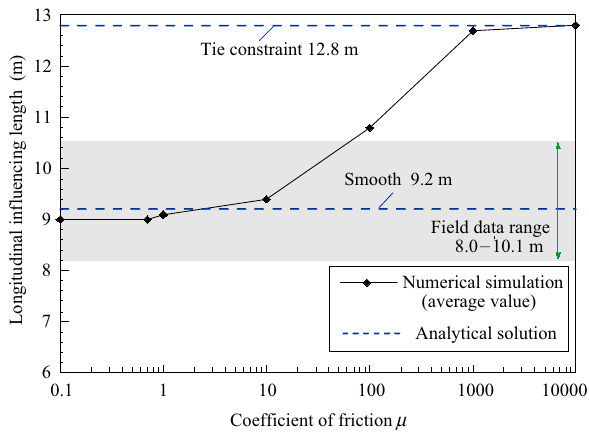
Fig. 6 Variation of numerical longitudinal influencing length of stress on roadbed with coefficient of friction, compared against the theoretical and field data [17]